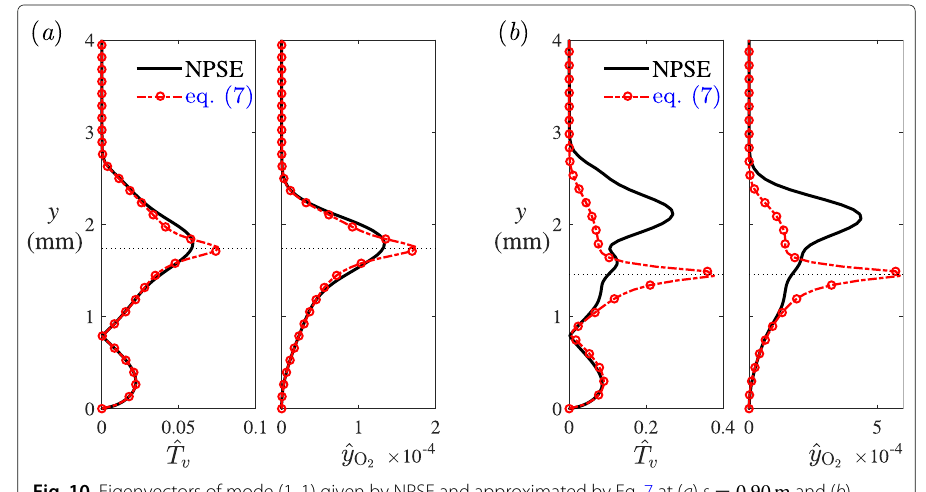
Fig. 10 Eigenvectors of mode (1, 1) given by NPSE and approximated by Eq. 7 at ( a ) s = 0.90m and ( b ) s = 1.03m TCNE flow as the boundary layer becomes cooler and thinner. Therefore, the maximum growth rate in the TCNE case is 16 % higher with f = 500 kHz and the peak location is shifted downstream. Seen from Fig. 11( c ), the differences between the maximum N fac- tors at these frequencies are ranging from 1.3 to 2.4. As a result, the envelop of the N factors in the TCNE flow moves upstream in the regime from 0.14 m to 0.25 m.